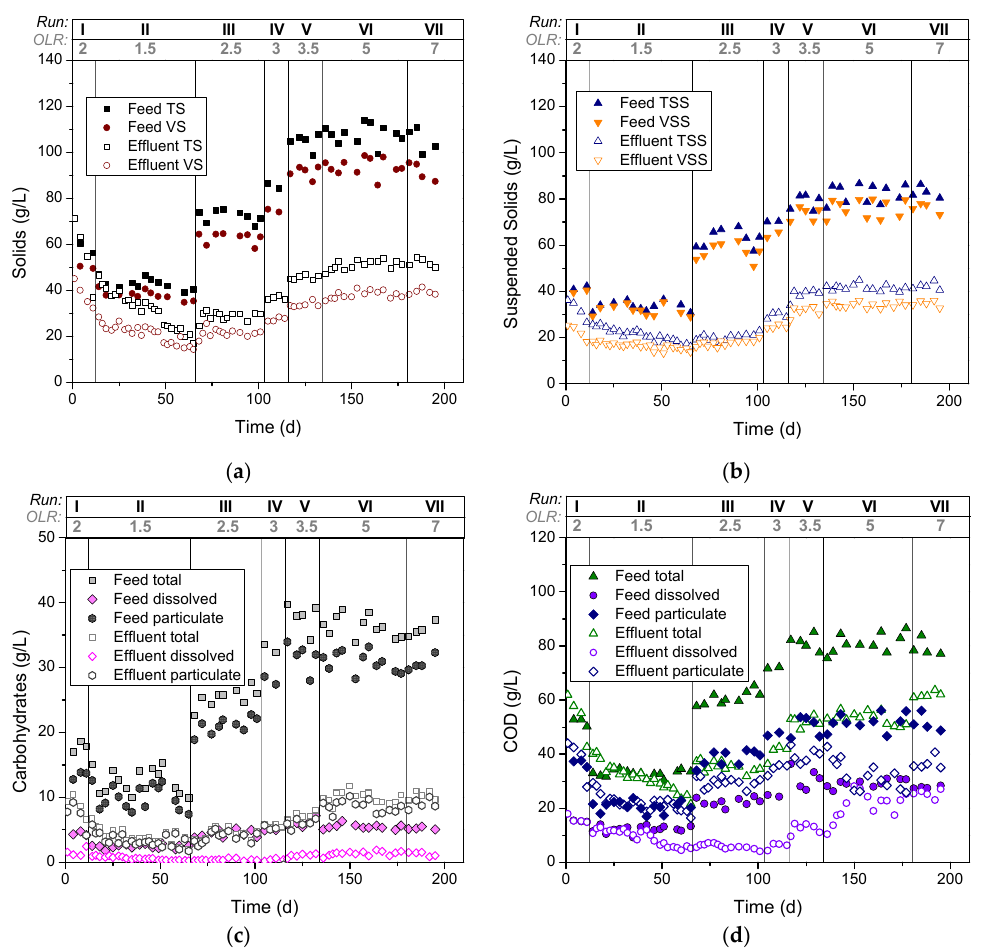
Figure 1. Northern Greece scenario: ( a ) Feed and effluent TS and VS concentration, ( b ) Feed and effluent TSS and VSS concentration, ( c ) Feed and effluent total, dissolved and particulate carbohy- drates concentration, ( d ) Feed and effluent total, dissolved and particulate COD concentration for all the tested runs.